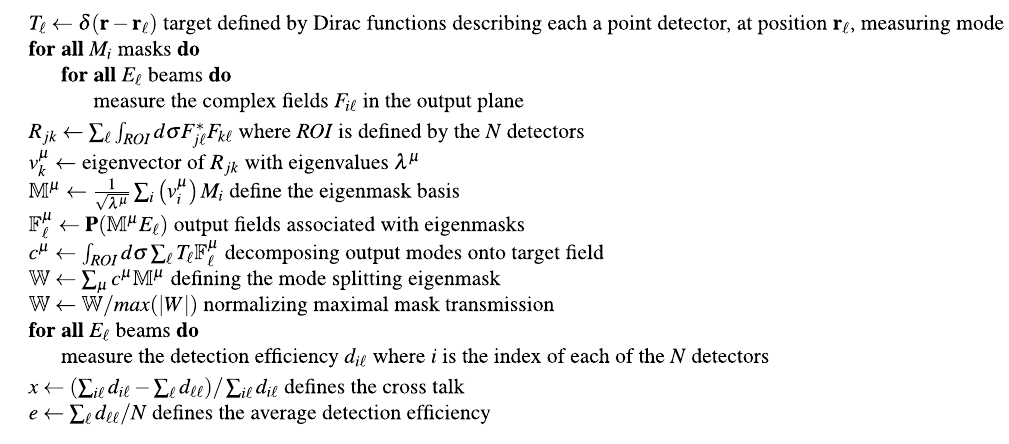
Algorithm 1. Determining the mode splitting